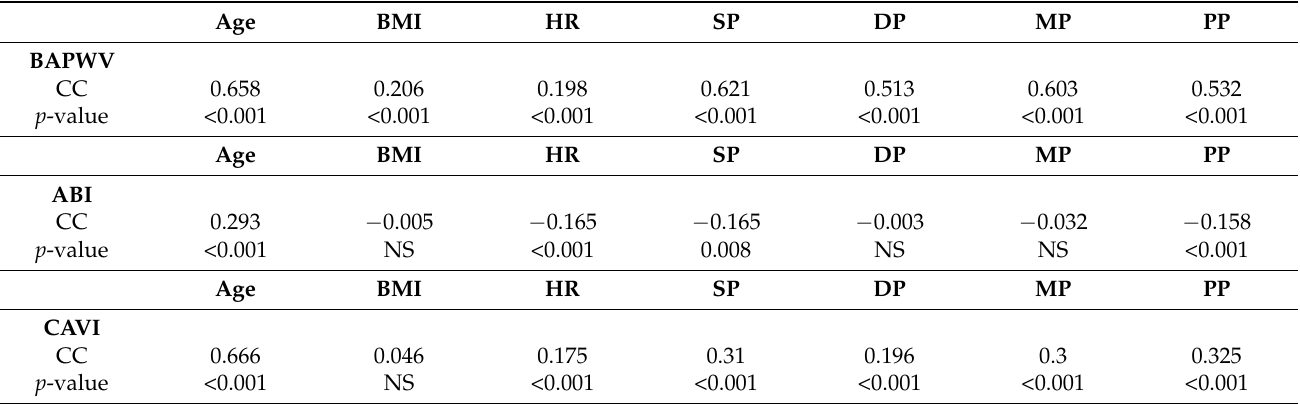
Table 2. Correlation between BAPWA (top) and ABI (bottom) with age, BMI, and hemodynamic